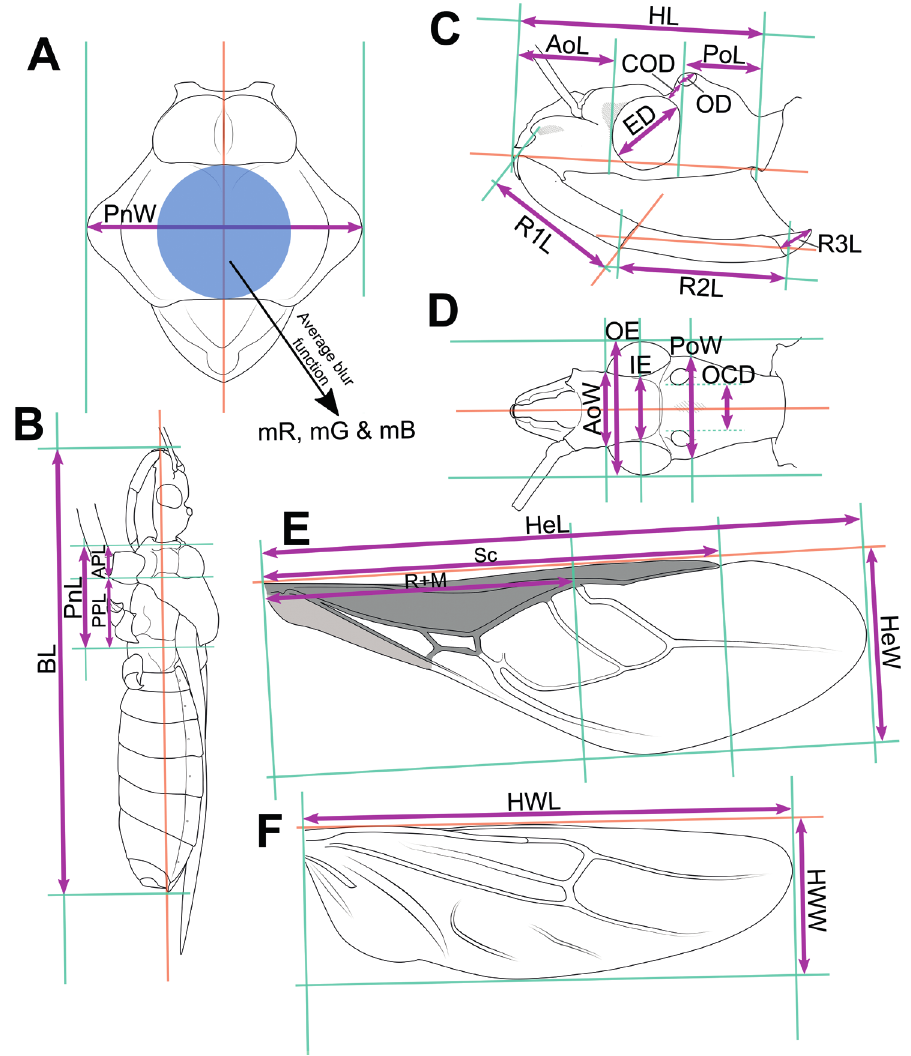
Figure 4. Measurement characters of Biasticus species. Drawing based on Biasticus luteicollis Ha, Truong & Ishikawa, paratype, sp. nov., ♀ , HNL2018-024. A pronotum and scutellum in dorsal view, the circle in the center of posterior pronotal lobe with the diameter equal to the minimum length of posterior pronotal lobe, at which the RBG color information was measured for calculating the average RBG color informa- tion in the form “mR”, “mG”, “mB” B body in lateral view C head in lateral view D head in dorsal view E hemelytron in dorsal view F hind wing in dorsal